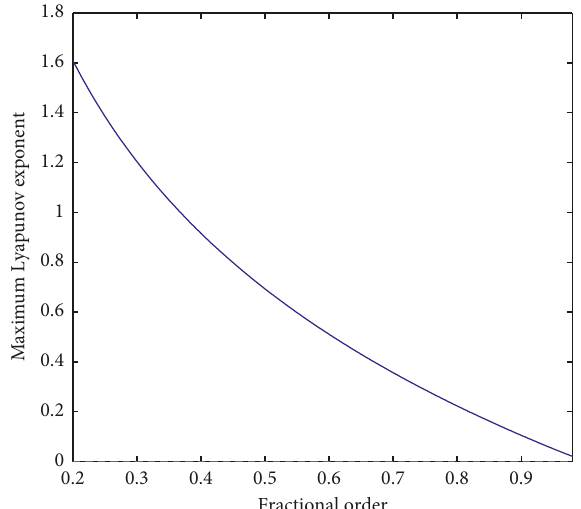
Figure 2: Maximum Lyapunov exponent of system (2) with respect to the fractional order σ